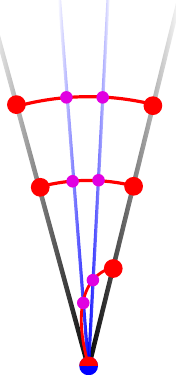
Figure 3. An example of an “excited state” for J = 2 . Here, propagators from the extra insertion of Φ at the cusp contract with the Wilson line without crossing any other propagators of Φ 1 in red), as such diagrams would be subleading in the ladders